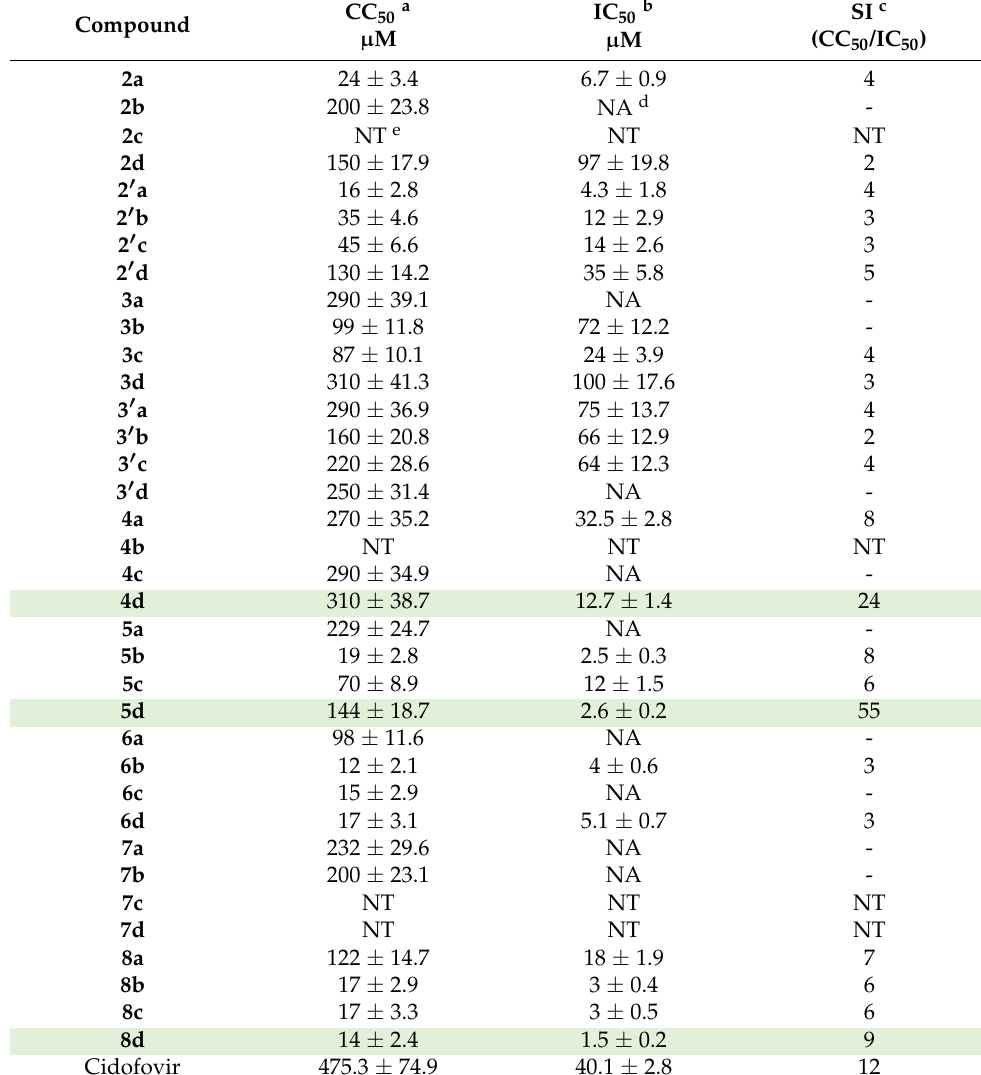
Table 2. Antiviral activity of synthesized compounds against VV.